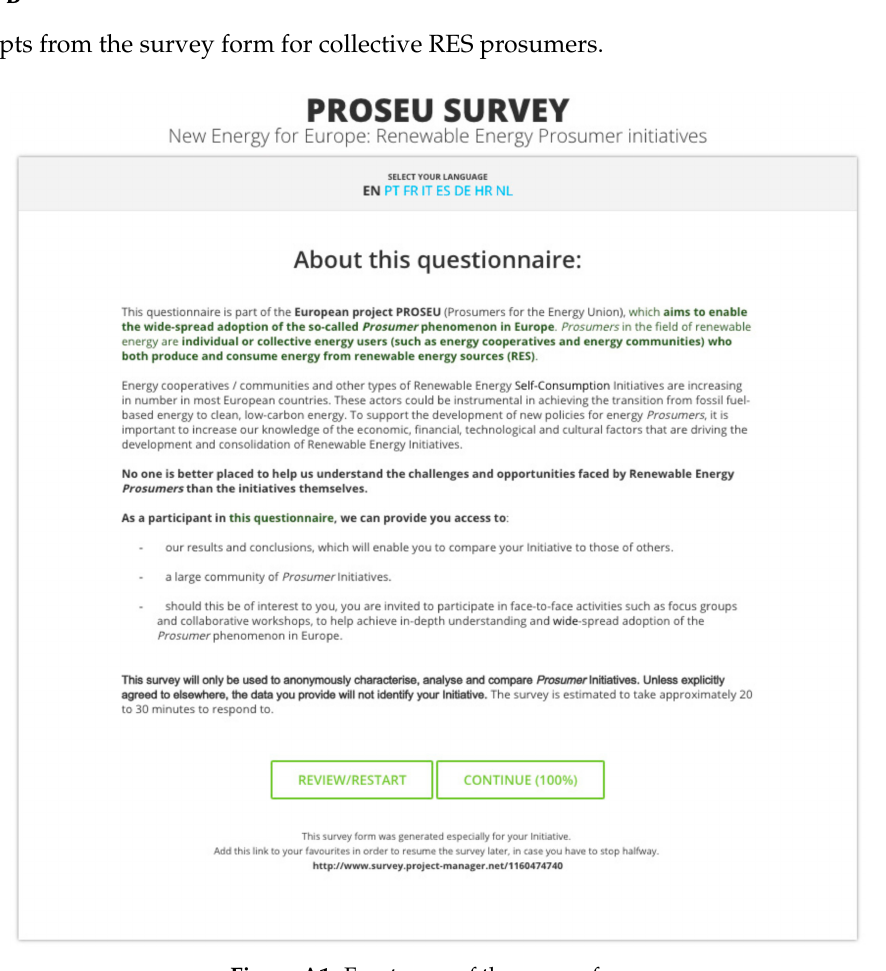
Figure A1. Front page of the survey